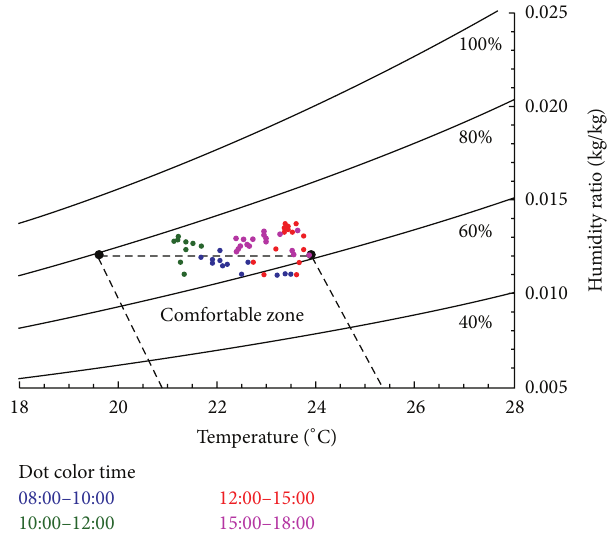
Figure 8: Dot distribution of the environment temperature, humid- ity, and thermal comfort in the summer before